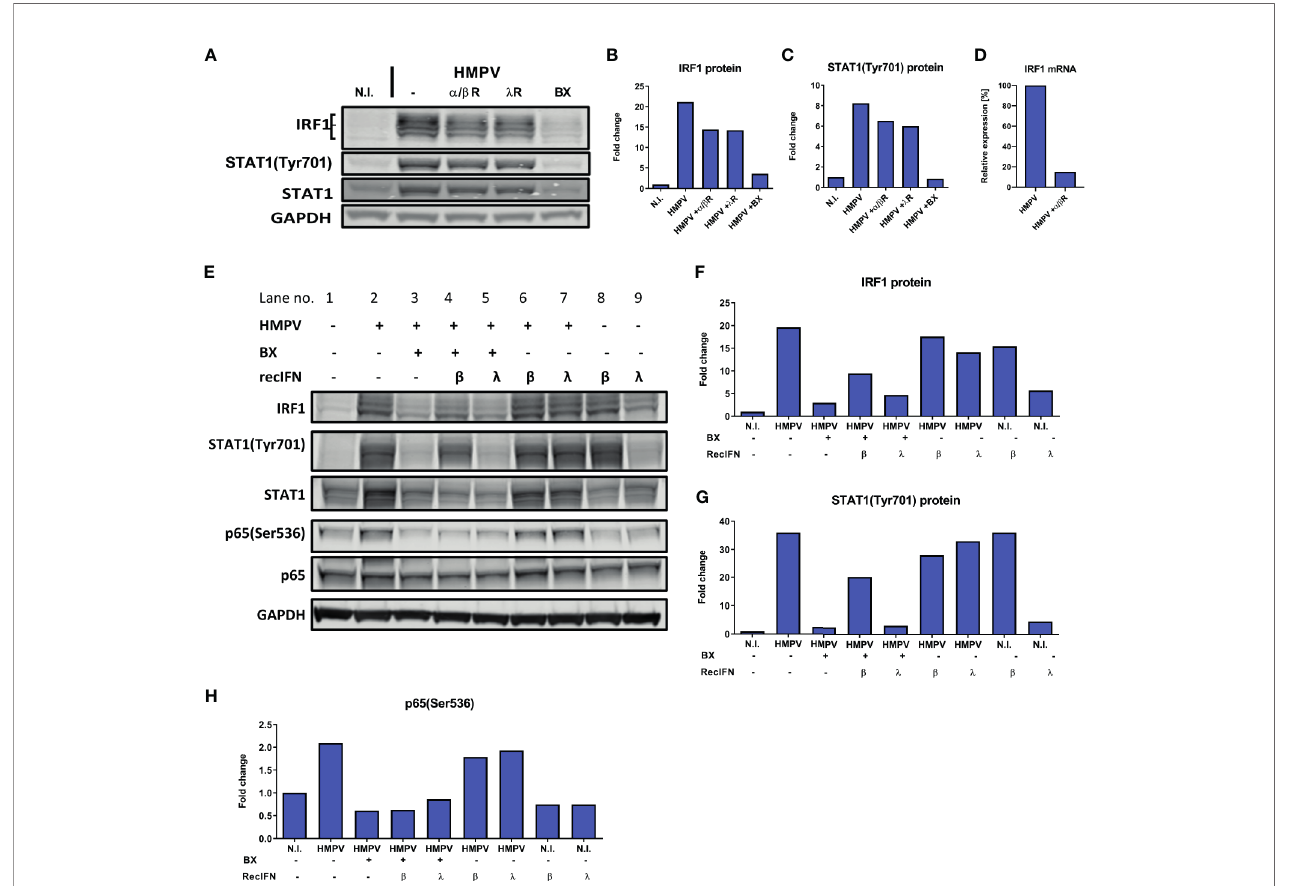
FIGURE 7 | Type I IFN signaling contributes to HMPV-induced expression of IRF1. (A – D) Human MDMs were incubated with neutralizing antibodies against IFN- a / b R ( a / b R) or IFN- l R ( l R), or BX795 (BX) prior to infection with HMPV. Protein levels of IRF1 and p-STAT1(Tyr701) were analyzed by immunoblotting (A) and quanti fi ed by normalization of band intensities against GAPDH and are presented as fold change relative to uninfected cells ( “ N.I. ” ) (B, C) . In (D) IRF1 mRNA expression was determined in MDMs treated with neutralizing antibodies against IFN- a / b R ( a / b R) prior to HMPV infection. IRF1 mRNA levels were normalized to HMPV-infected cells. (E – H) Human MDMs were incubated with BX795 prior to infection with HMPV or treatment with medium (N.I.). After 15 h, recombinant IFN- b , IFN- l 1 or medium were added for 3 h. IRF1 (F) , p-STAT1(Tyr701) (G) and p-p65(Ser536) (H) protein levels were analyzed by immunoblotting, quanti fi ed by normalization of band intensities against GAPDH and are presented as fold change relative to uninfected cells ( “ N.I. ” ). Data are representative of three (A – D) or two (E – H) independent biological